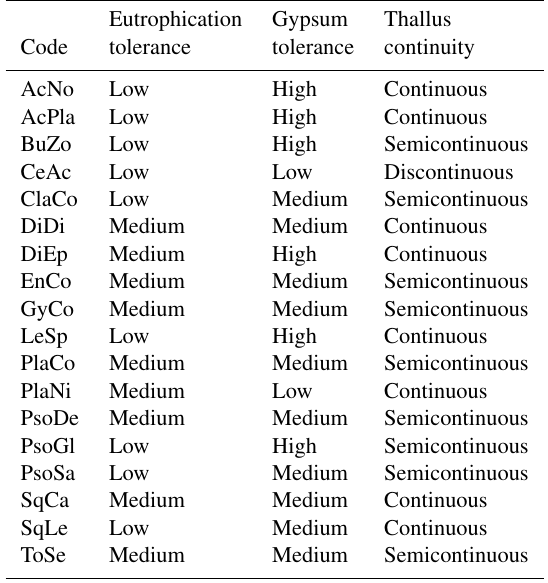
Table 2. Biocrust species and functional trait categories. See Ta- ble 1 for species